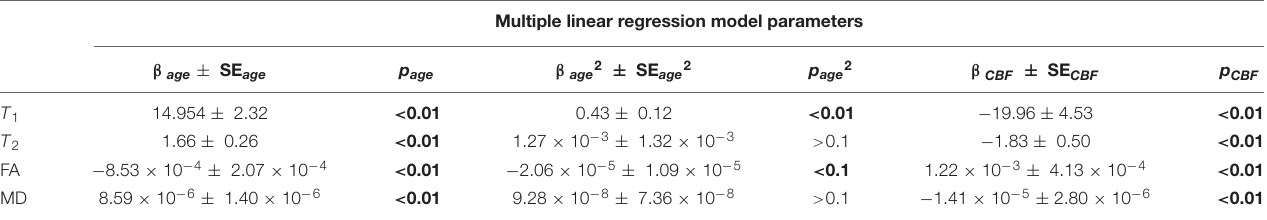
TABLE 2 | Coefficients of regression ± standard error (SE) and p -values of age, age 2 , and CBF of the multiple linear regression analysis of T 1 , T 2 , FA, or MD. Multiple linear regression model